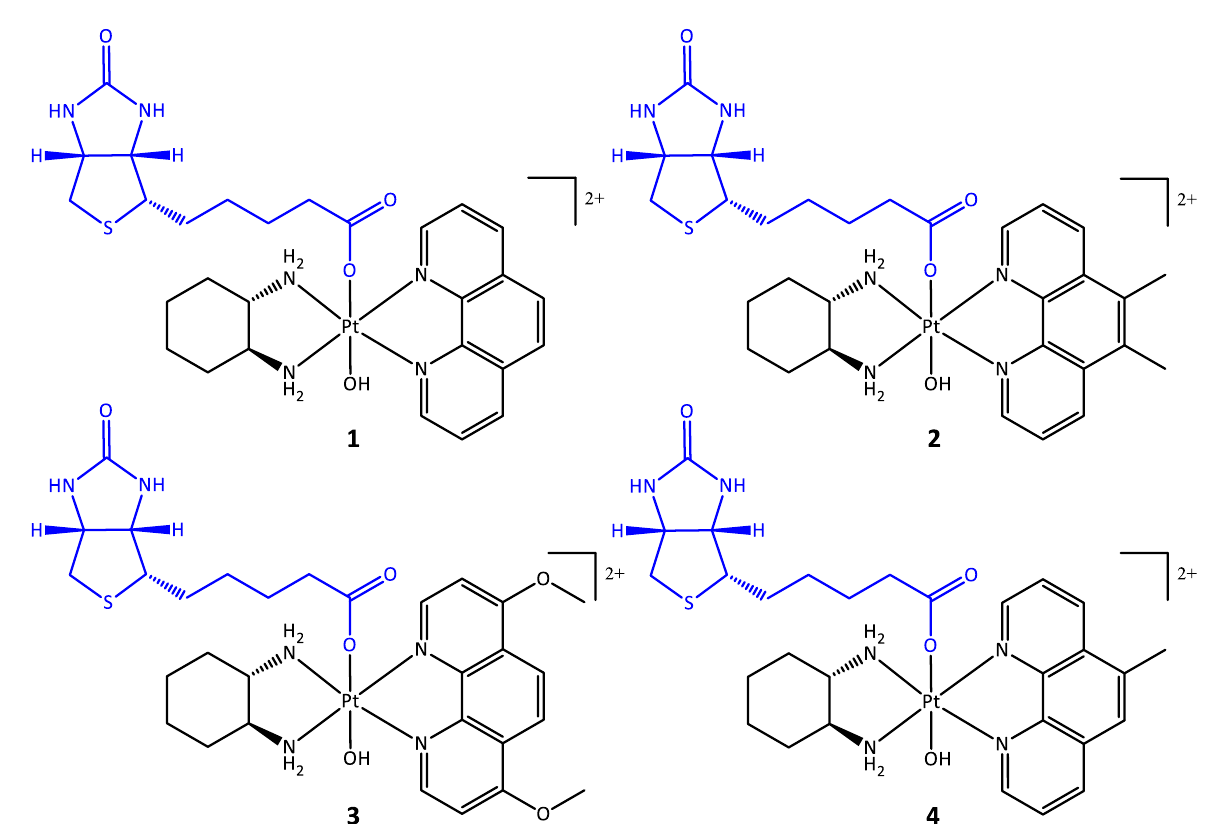
Figure 3. The chemical structures of complexes 1 – 4 comprised of biotin (blue) conjugated to different platinum cores (black) PHENSS ( 1 ), 56MESS ( 2 ), 47OMESS ( 3 ), and 5MESS ( 4 ).